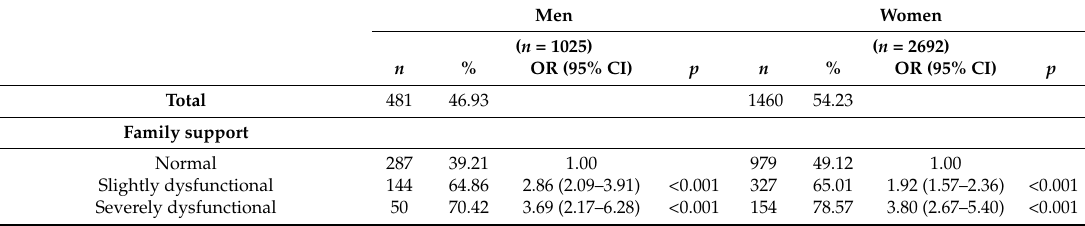
Table 2. Distribution of the prevalence of psychological distress in terms of population characteristics by gender. Bivariate analysis. UniHcos project